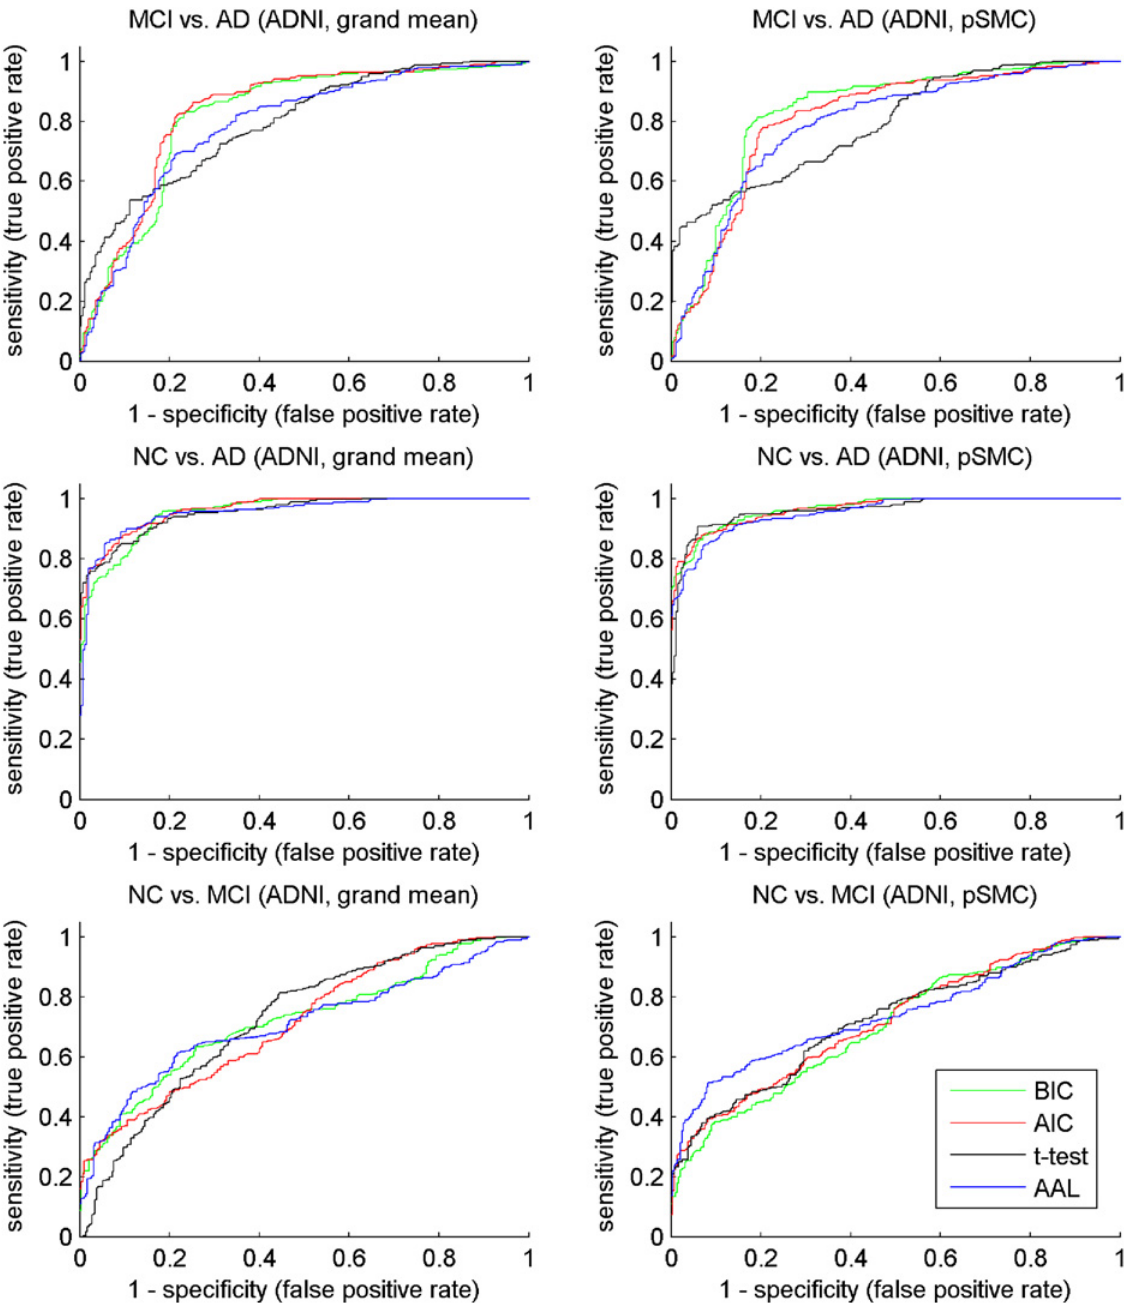
Fig 5. ROC curve of compared method on ADNI dataset. To plot the curve, we collected the predicted probabilities for all the test sets in 10 times 10-fold cross-validation, along with their true class labels. For the plotting of ROC curves, we refer to page 173 of the book by Witten et al. [42].